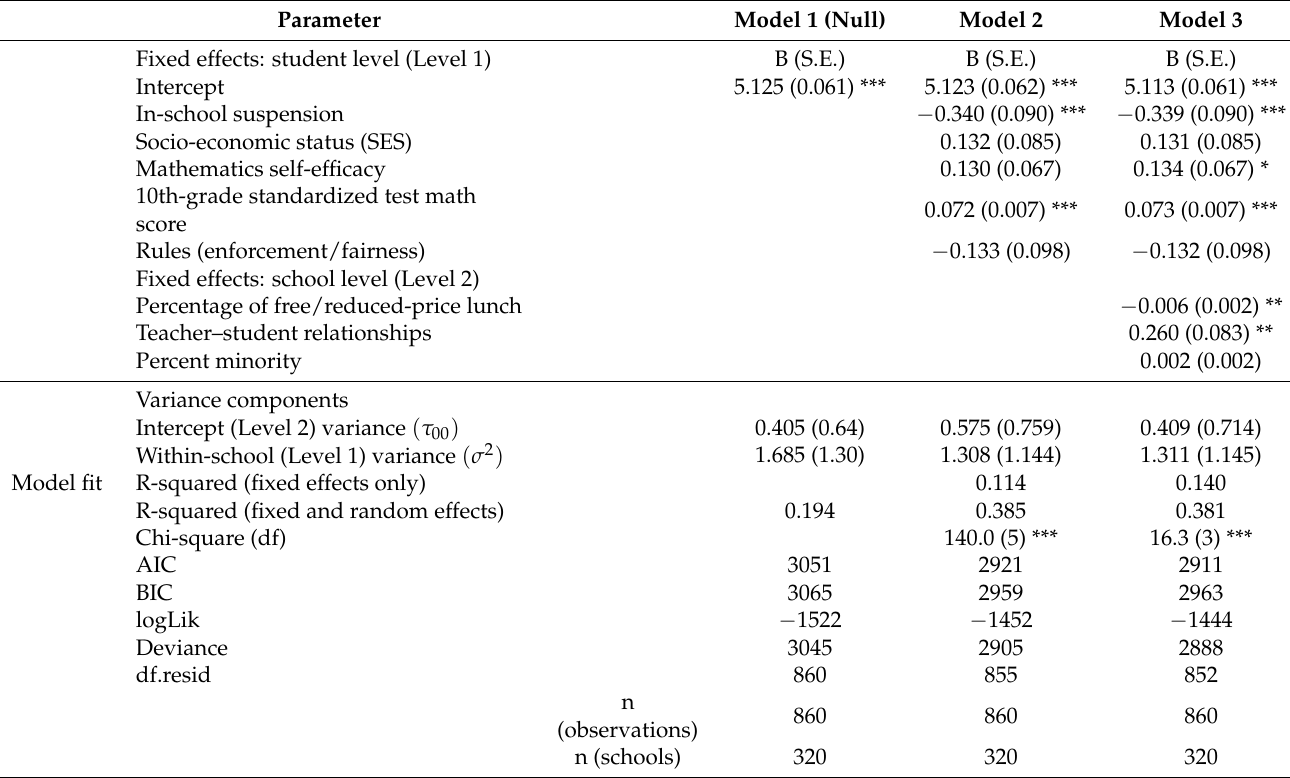
Table 5. Multi-level and hierarchical regression estimates for the course-taking